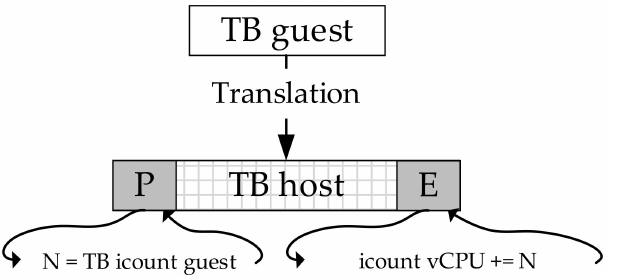
Figure 6. Block diagram to define how to get instruction counter in the TB host using prologue and